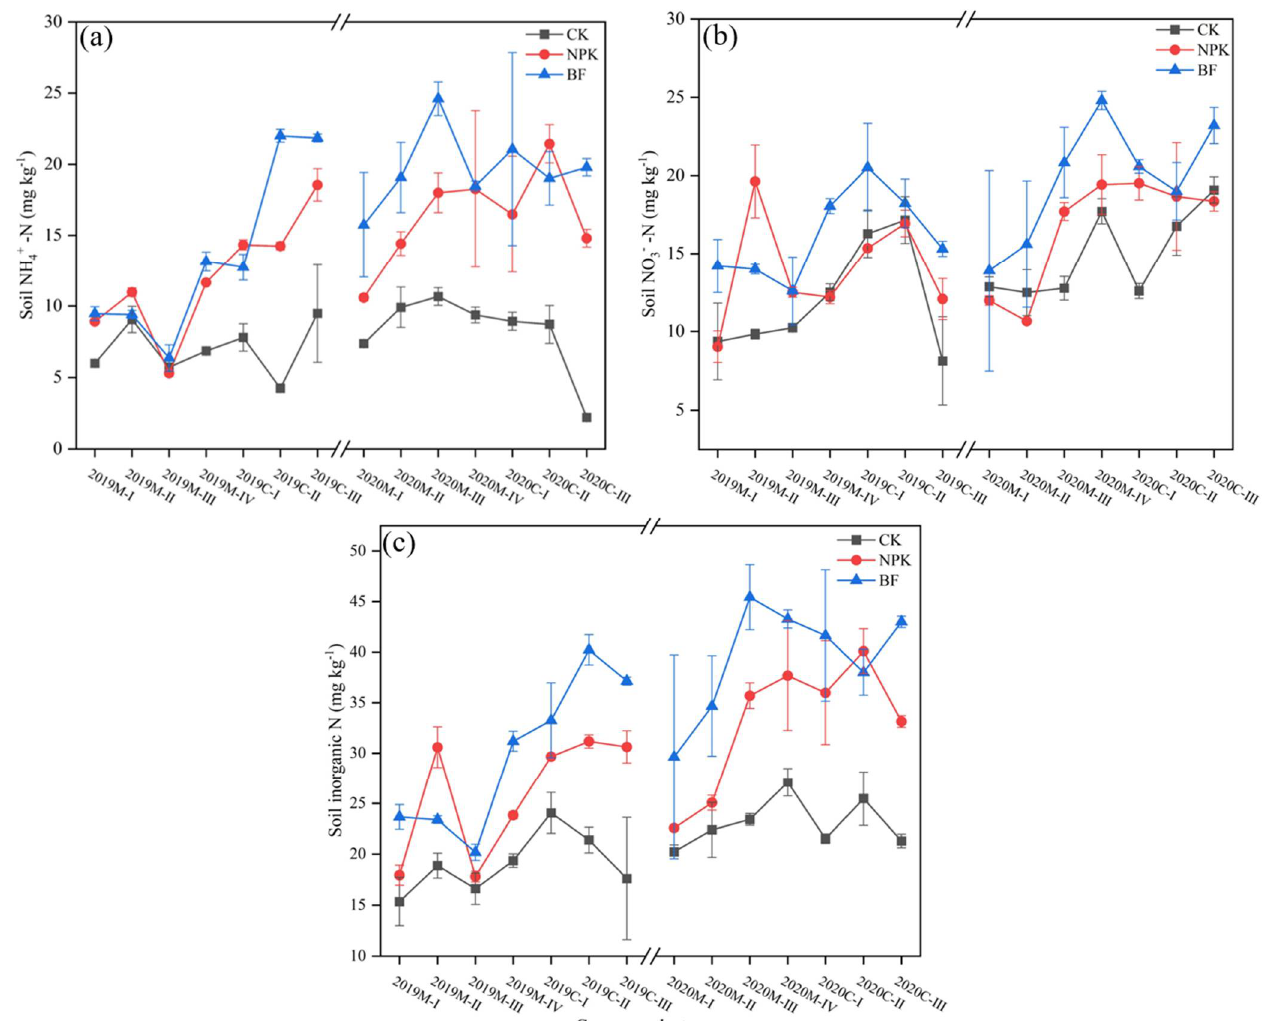
Figure 7. Dynamic changes in the soil NH 4+ -N, NO 3− -N, and inorganic N levels under different fertilization treatments of maize and cabbage at different growth stages between 2019 and 2020. ( a ), The dynamic changes in soil NH 4+ -N ( b ), the dynamic changes in soil NO 3− -N ( c ), The dynamic changes in soil inorganic N. 2019M- Ⅰ , 2019M- Ⅱ , 2019M- Ⅲ , and 2019M- Ⅳ represent the seedling stage, jointing stage, heading stage, and harvest stage of maize, respectively, in 2019. 2019C- Ⅰ , 2019C- Ⅱ , and 2019C- Ⅲ represent the seedling stage, rosette stage, and harvest stage of cabbage, respec- tively, in 2019. 2020M- Ⅰ , 2020M- Ⅱ , 2020M- Ⅲ , and 2020M- Ⅳ represent the seedling stage, jointing stage, heading stage, and harvest stage of maize, respectively, in 2020. 2020C- Ⅰ , 2020C- Ⅱ , and 2020C- Ⅲ represent the seedling stage, rosette stage, and harvest stage of cabbage, respectively, in 2020. The error bars show the standard deviations of the means (n = 3).